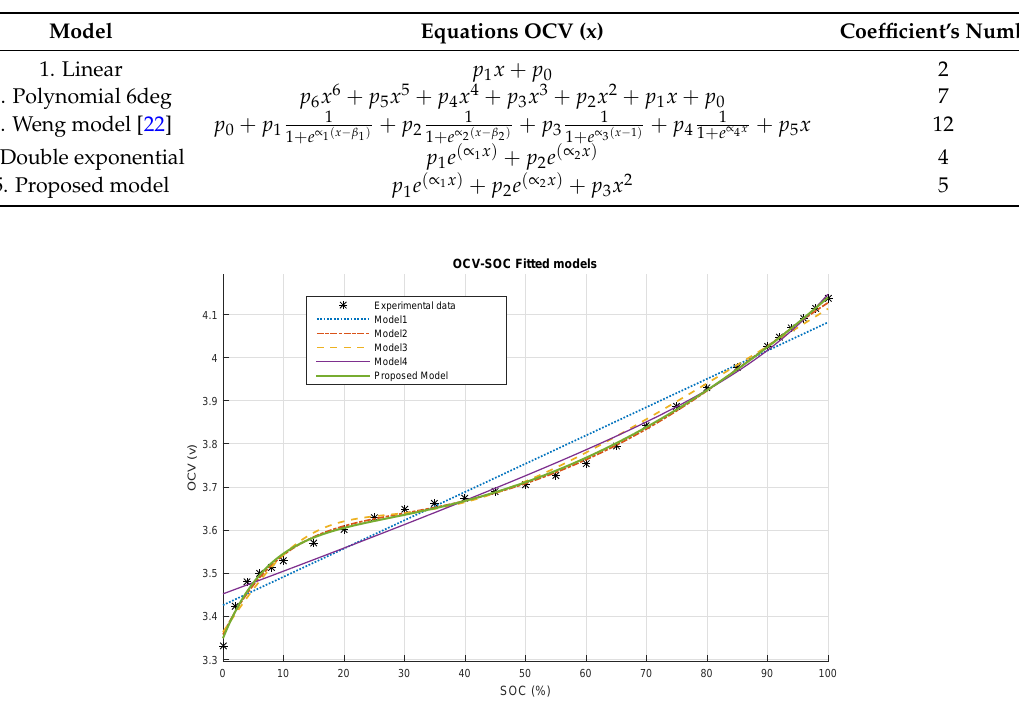
Table 4. Summary of the studied OCV models.